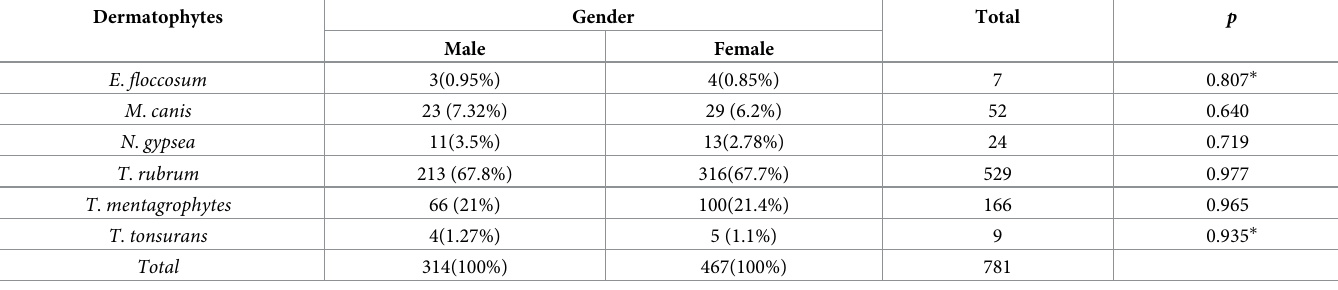
Table 3. Gender distribution of dermatophyte species isolated from the 781 diseased patients.